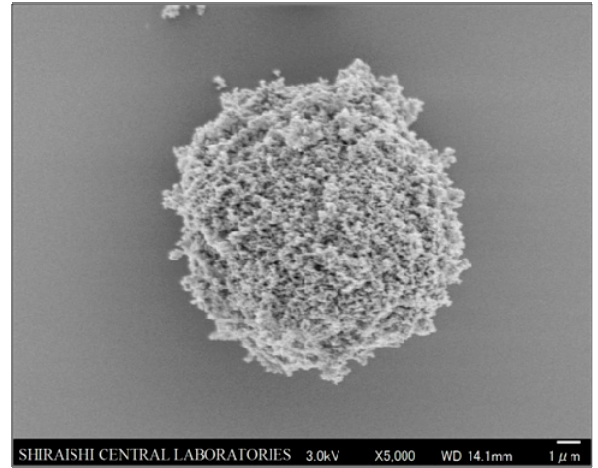
Figure 4. A typical field-emission scanning electron microscopy image of an agglomerate of the lightly fatty acid-coated CaCO 3 particles.